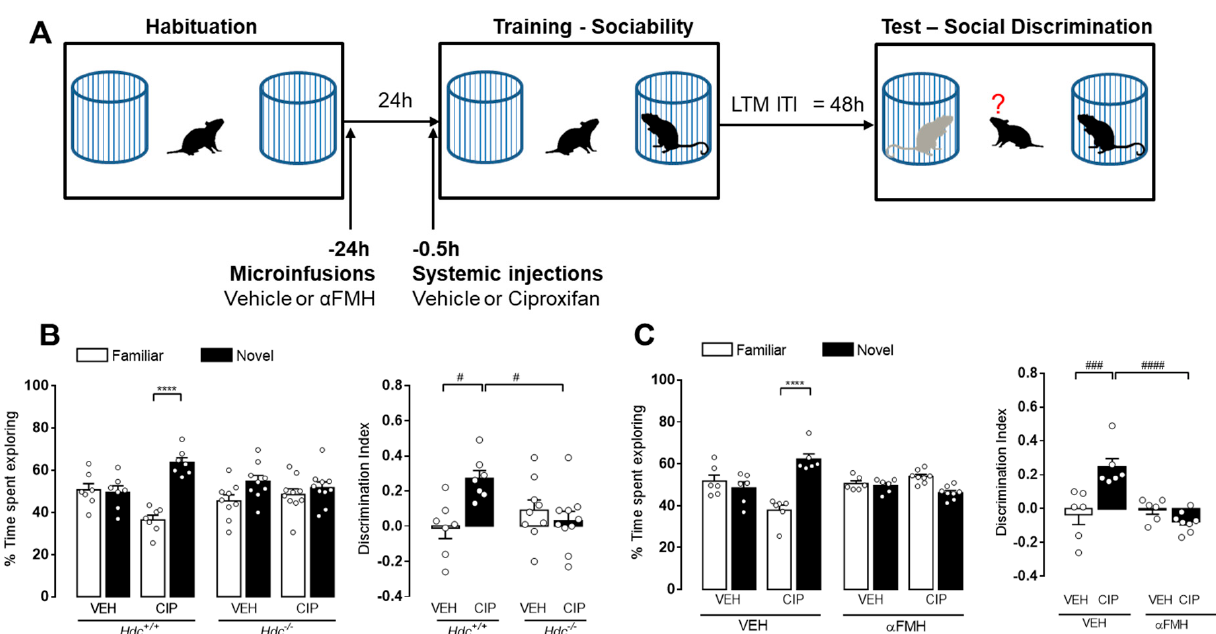
Figure 6. Increased cholinergic transmission prevents H 3 R agonist-induced amnesia. ( A ) Schematic drawing showing the sequence of the behavioral procedures. Different groups of Hdc +/+ male mice received donepezil (3 mg/kg, i.p.) or vehicle injections and 15 min latter an i.p. injection of VUF16839 (5 mg/kg). Training session was carried out 30 min after the VUF16839 injection. Retention tests were performed 1 h after training. ( B ) The animals’ performance is shown as means ± S.E.M. (10 animals per experimental group). **** p < 0.0001 by two-way ANOVA and Bonferroni’s MCT; ## p < 0.001 by unpaired t -test.